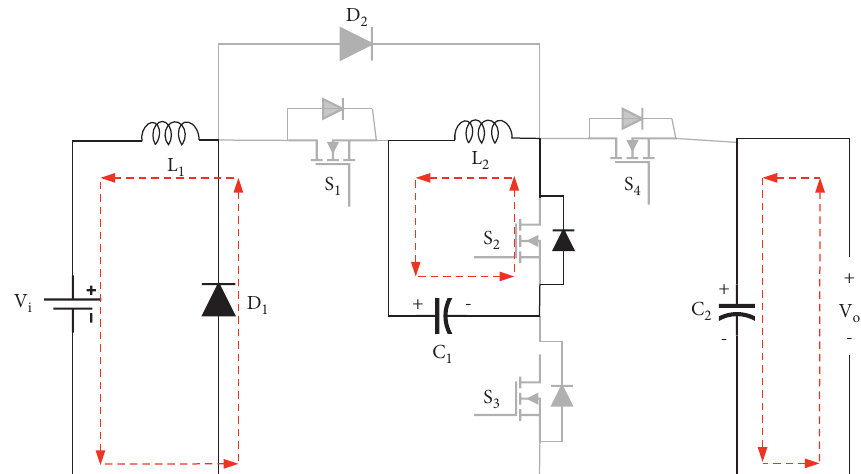
Figure 7: Converter buck mode operation in mode